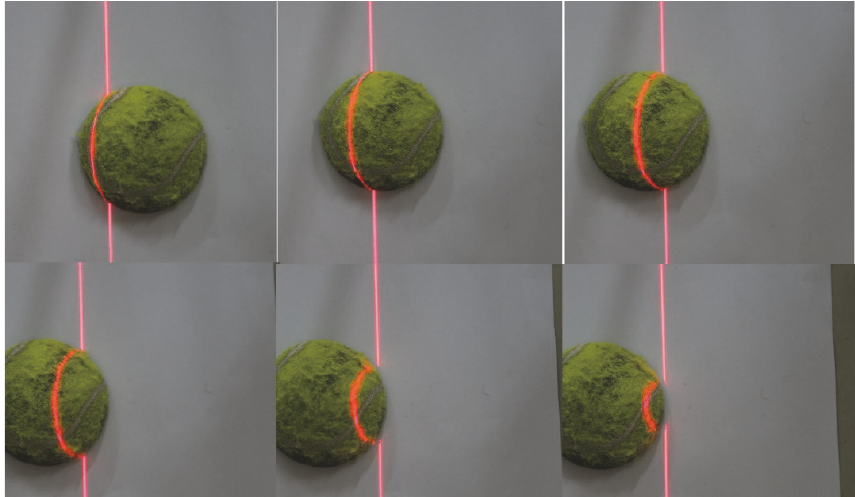
Figure 10: Hemispherical picture taken in